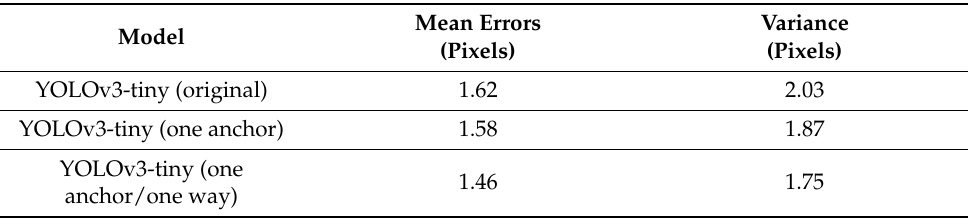
Table 5. Comparisons of the visible-light pupils’ center tracking errors among the three YOLO-based models by using the datasets of person 1 to person 8 for the training